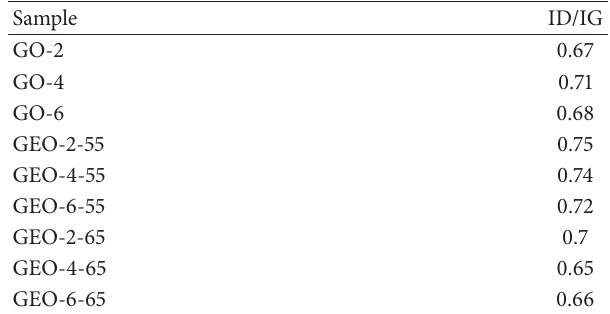
disorder. Changes in the Raman spectra occur due to changes Table 1: ID/IG and IG/ID ratio values in the Raman